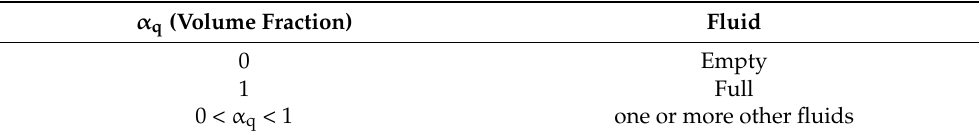
Table 1. Volume fraction in multiphase